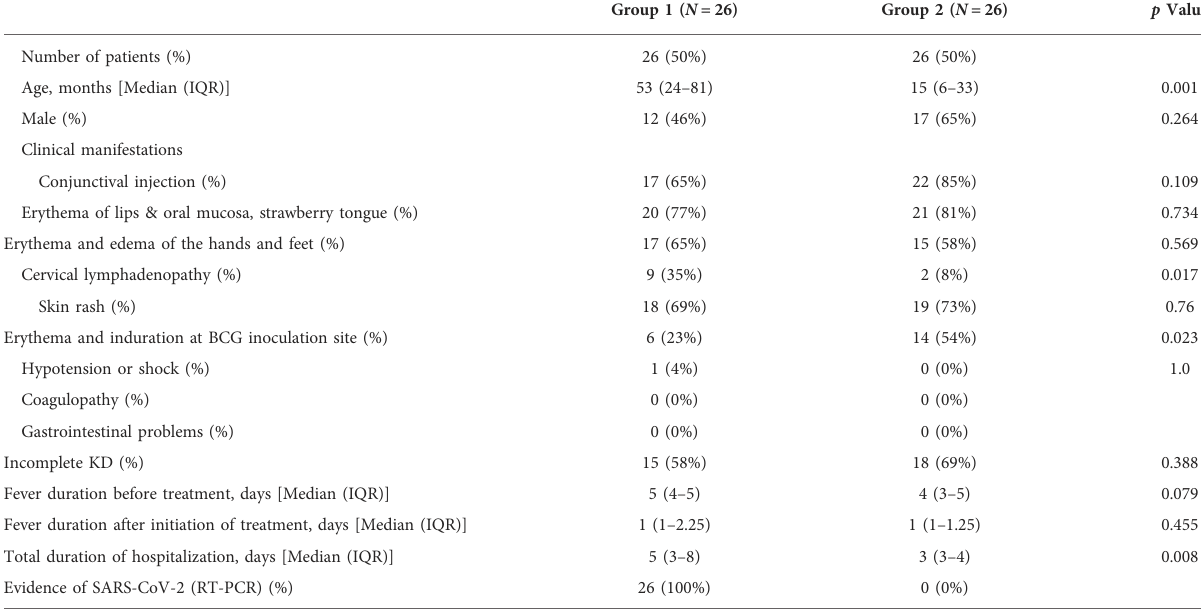
TABLE 1 Comparison of the demographic and clinical characteristics between the groups.